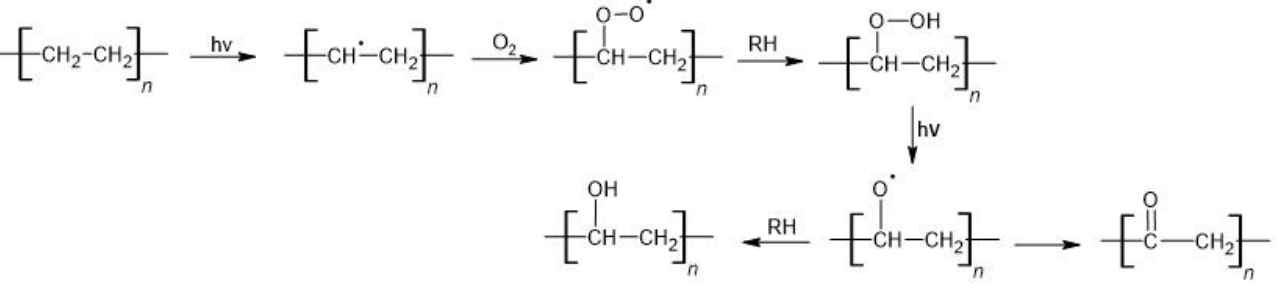
Figure 3. Photodegradation of PE (hν — to add energy via photons, RH —inclusions).